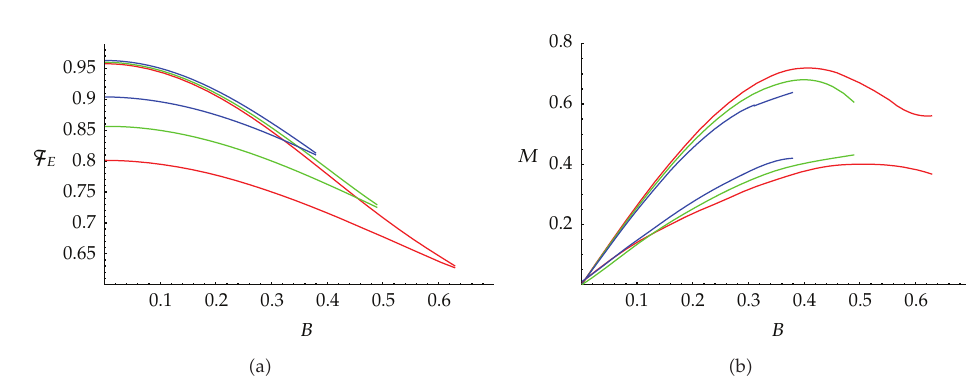
Figure 12: The free energy and magnetization of the multiquarks nuclear matter at fixed j A (cid:8) 0 , d (cid:8) 1, and T (cid:8) 0 . 10 for n s (cid:8) 0 (cid:3) red (cid:4) , 0.10 (cid:3) green (cid:4) , 0.20 (cid:3) blue (cid:4) . The upper lines are the configuration A with u c close to u T , and the lower lines are the configuration B with large separation between u c and u T